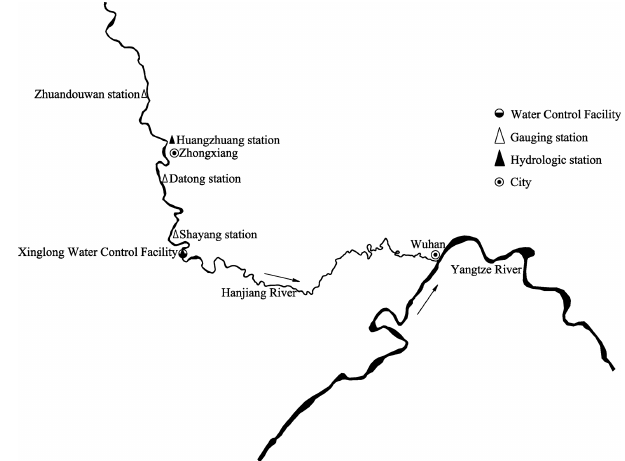
Figure 1. Sketch map of the research river.